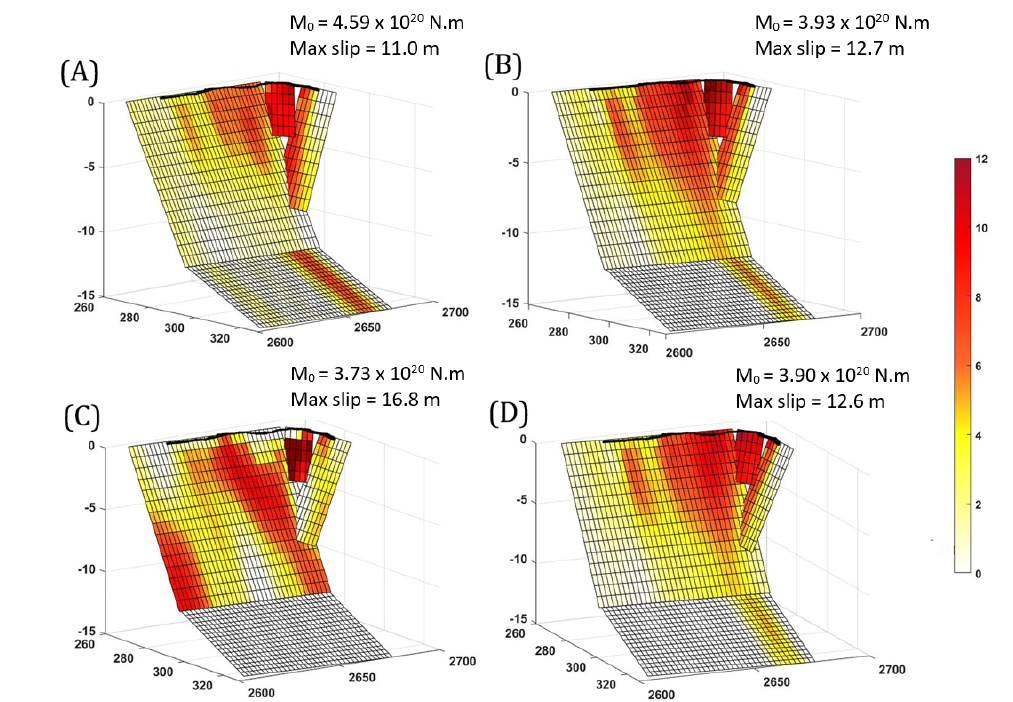
Figure 9. Slip distribution model. Inversion based on ( A ) GPS data and three interferograms (Table 1) with all the weights set to 1; ( B ) same data sets but with the relative weights estimated by gABIC (GPS 1, 0.09, 0.10, 0.10 for the three interferograms). All the data sets were included in ( C , D ). ( C ) The relative weights are set to 1; ( D ) the relative weights ([GPS, levelling, Benchmarks, Interferogram 1, 2, 3,